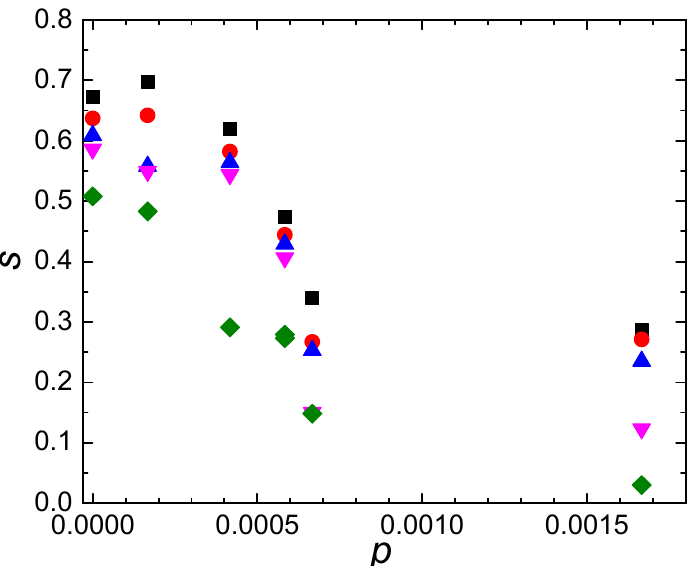
Figure 2. Nematic orientational order parameter S as a function of nanoparticle concentration 𝑝 at different temperatures ∆𝑇 below the isotropic to nematic phase transition temperature 𝑇 (cid:3010)(cid:3015) ( █ - ∆𝑇 = 19.4 K ± 1.4 K, ● - ∆𝑇 = 15.0 K ± 0.7 K, ▲ - ∆𝑇 = 10.0 K ± 0.7 K, ▼ - ∆𝑇 = 5.0 K ± 0.7 K, ◆ - ∆𝑇 = 1.0 K ± 0.7 K).